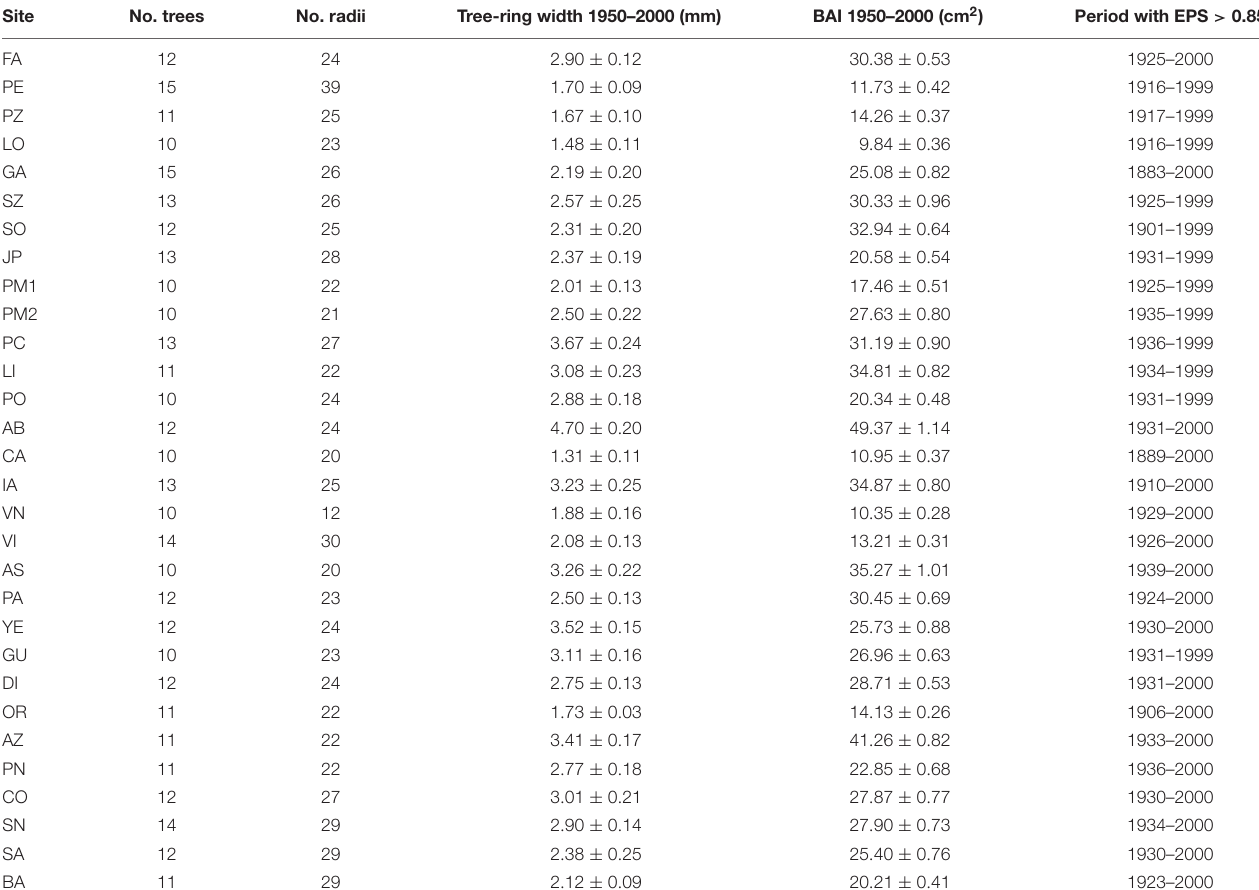
TABLE 2 | Descriptive statistics of the tree-ring width and basal area increment